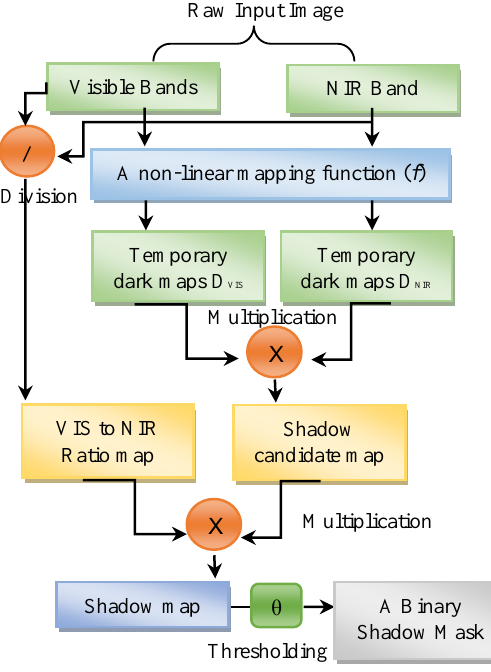
Figure 3. Shadow detection framework. Modified after Rufenacht et al. (2014).